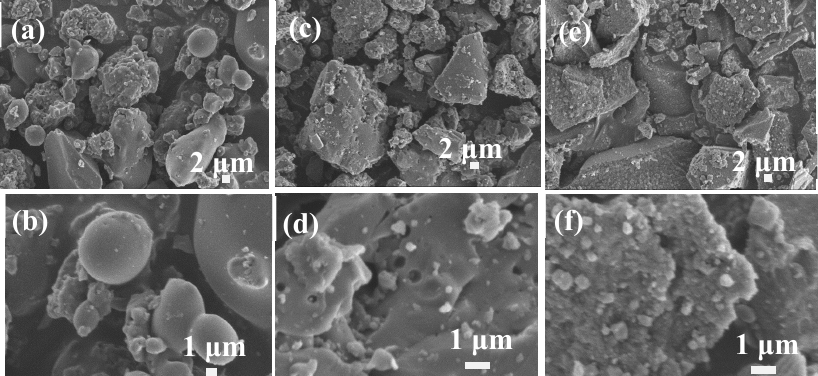
Figure 3. SEM images of lignin-based carbon materials using Longlive lignin as precursor in different ZnCl 2 solution: ( a,b ) 10 wt %, ( c,d ) 20 wt %, and ( e,f ) 60 wt %.